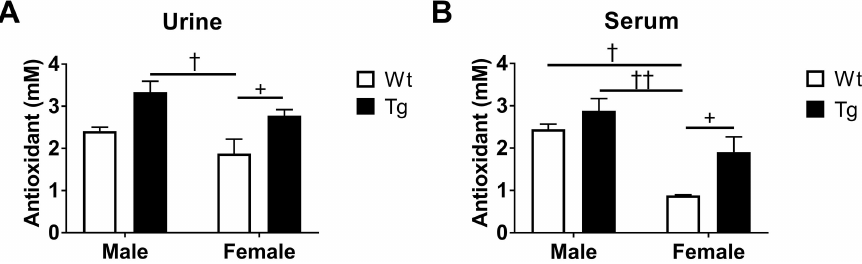
Fig 5. Total antioxidant capacity content in (A) urine and (B) serum samples of male and female mice at 24-month of age. Genotype effect (Wt v.s. Tg): +P < 0.05.Gender effect (Male v.s. Female): †P < 0.05, ††P < 0.01.All data are expressedas Mean ± SEM, N = 5 mice/group.